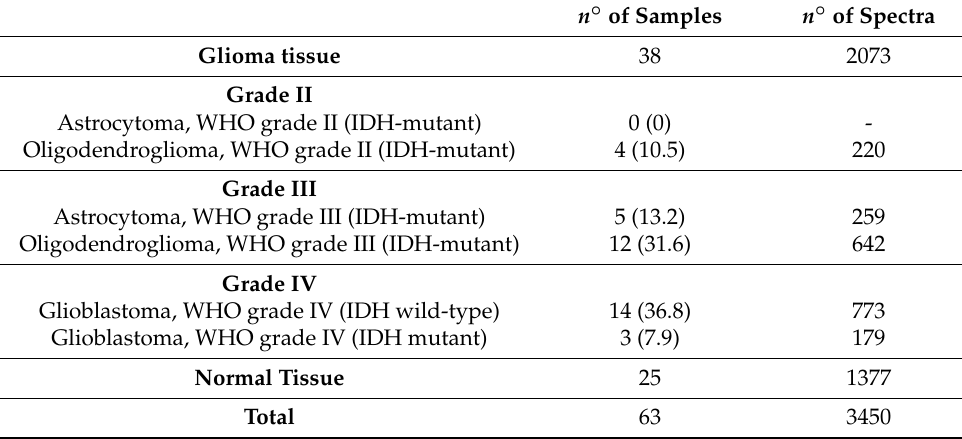
Table 1. Numbers of specimens and histological diagnosis. n ◦ : numbers.